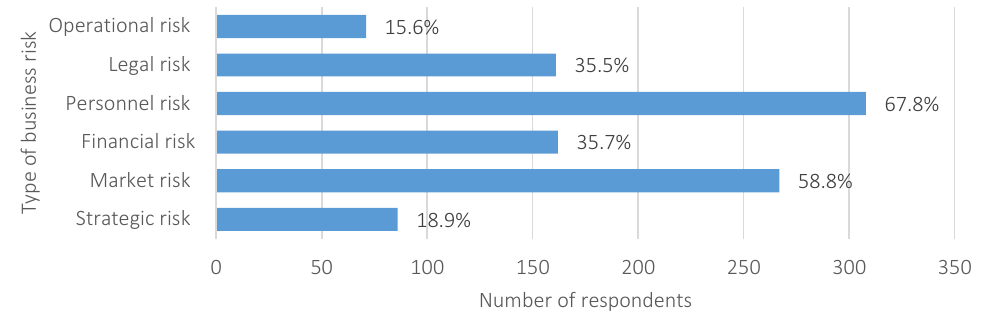
Figure 1. The most significant business risks according to the attitudes of the